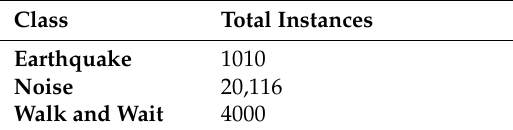
Table 3. Dataset used for models training and testing in a static environment.